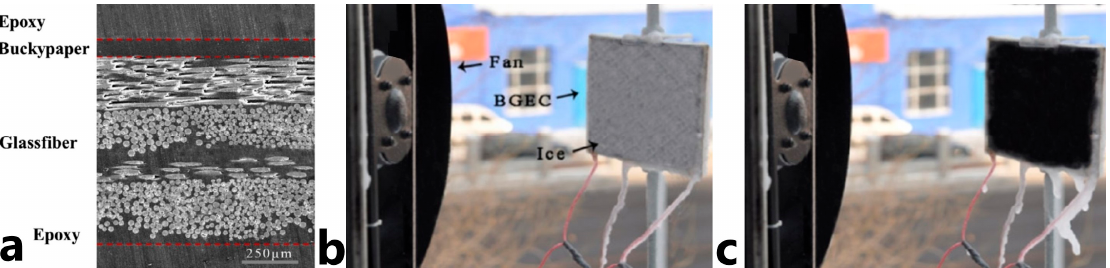
Figure 6. ( a ) SEM image of the cross-section of the buckypaper-FRPC heater, and ( b ) image of buckypaper-FRPC heater before ( c ) and after de-icing at − 22 °C and wind speed 14 m/s (Reprinted with permission from Elsevier, copyright 2014) [60].